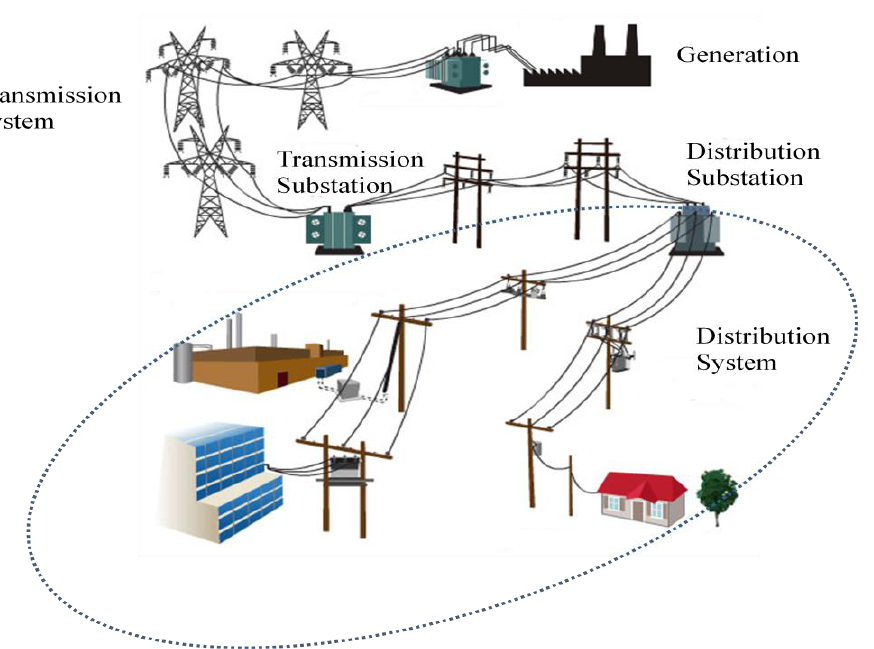
Figure 1. An example of a power